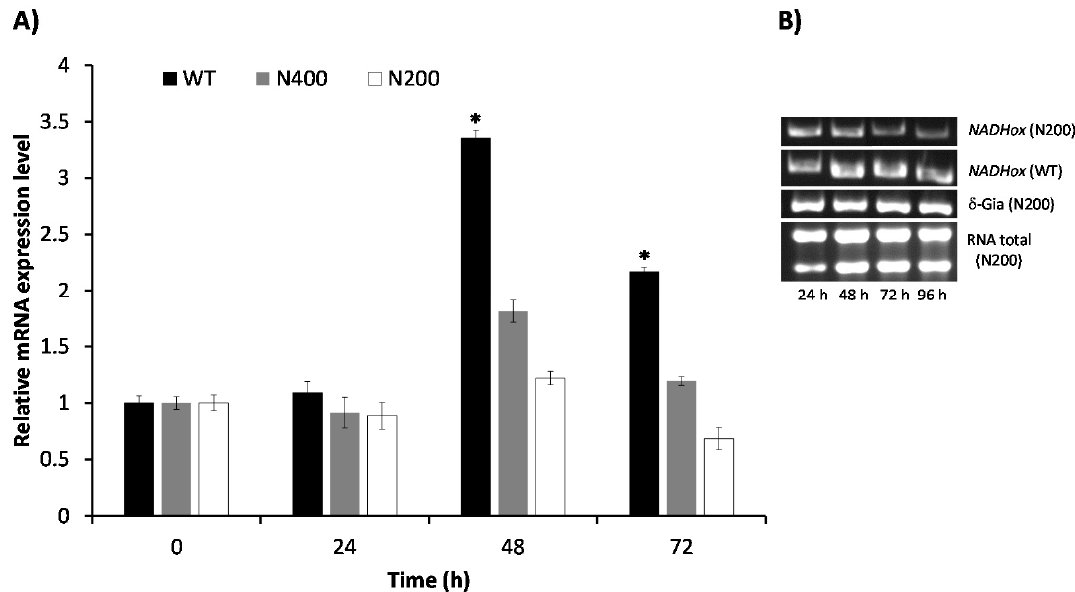
Figure 4. Quantification of NADHox mRNA in the wild type (WT) and transformants with a silenced NADHox . ( A ) Kinetics of mRNA expression of the NADHox gene from the WT strain (black bars) and the N200 (white bars) and N400 (gray bars) transformants. mRNA quantitation was performed by RT-qPCR (see Materials and Methods). The primers used for analysis of the NADHox and Act transcripts were qNADH and qAct , respectively (Table 1), using the actin gene ( Act ) (GenBank id: XM_001704601) as housekeeping gene control. The figures represent the average of three independent experiments with three replicates each experiment and in real time each replicate was quantified 5 times. The results at 48 and 72 h of cultivation showed significant differences between strains (* p < 0.01 with one-way ANOVA). ( B ) The transcript levels of the NADHox gene at different times was also determined by semiquantitative RT-PCR for the WT strain and N200 transformants; the δ -Gia gene was used as housekeeping